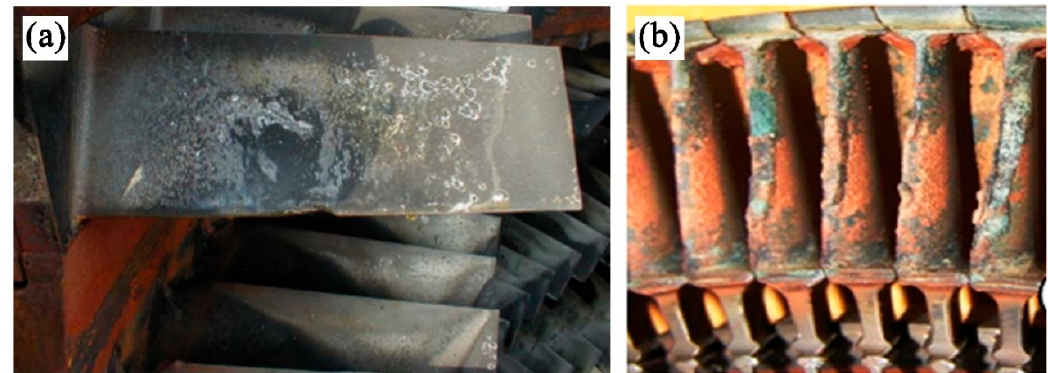
Figure 1. Illustration of degradation damages on the surface of: ( a ) compressor blades, and ( b ) turbine blades. Reproduced with permission from [17]. ASME, 2006.